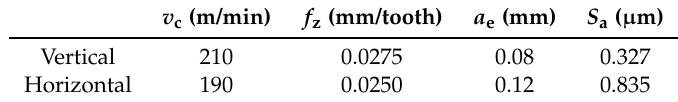
Table 17. Optimized factor levels for milling of vertical and horizontal